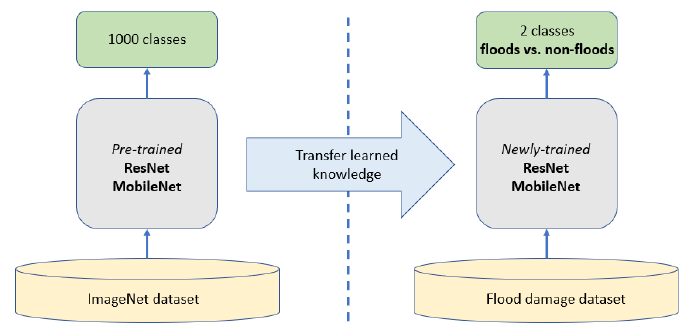
Figure 1. The transfer learning workflow for binary classification into floods and non-floods by using pre-trained ResNet and MobileNet.